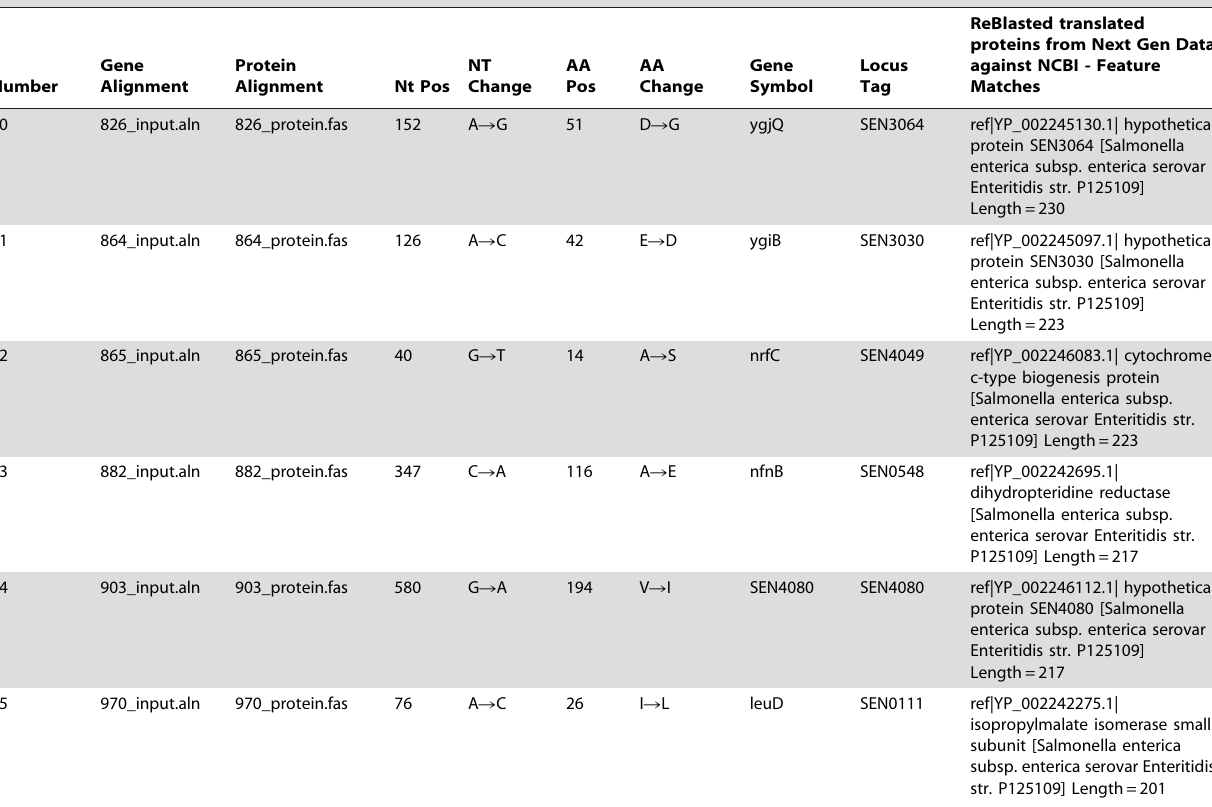
Variable genes observed that may define Salmonella